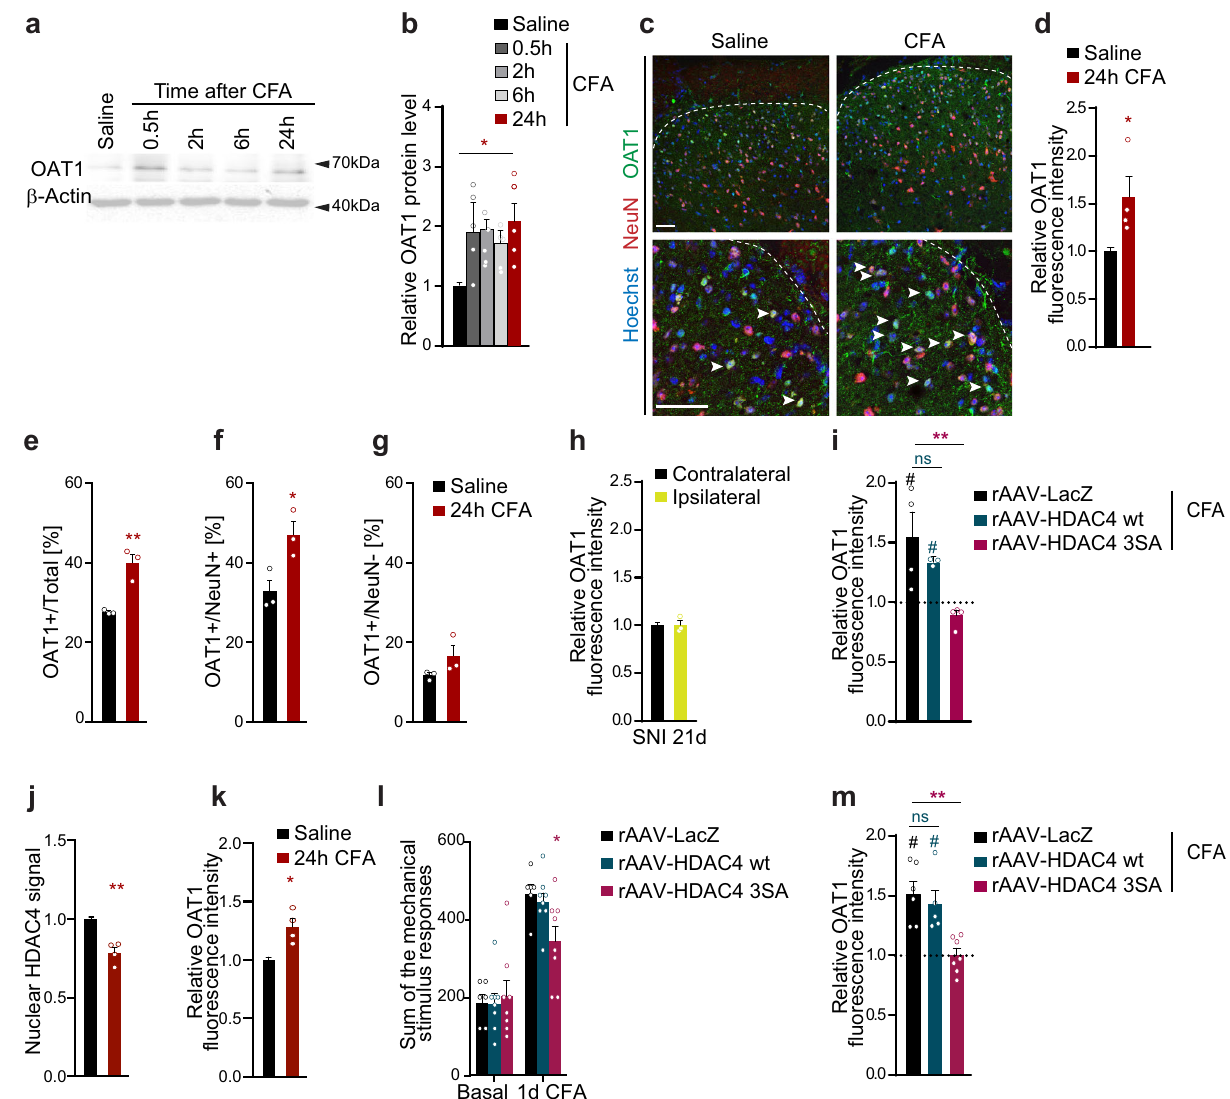
Fig. 4 Activity of the HDAC4 target OAT1 in the spinal cord mediates mechanical hypersensitivity. a Immunoblots of OAT1 and β -Actin from dorsal spinal cord segments L3 – 5. b Relative protein levels of OAT1 and β -Actin normalized to values from saline-injected control mice ( n = 5). c Representative images of dorsal horn sections of spinal segments L3 – 5 of mice 24 h after injection, OAT1 (green), NeuN (red, neuronal marker), Hoechst (blue, nuclear marker). Lower panels are a higher magni fi cation. Arrows indicate OAT1-positive and NeuN positive cells. Scale bars are 40 µ m. d Relative OAT1 immuno fl uorescence intensity in dorsal horn following injections as in ( c ) ( n = 4). e – g Co-localization analysis of OAT1-positive cells in the dorsal horn following injections 24 h earlier. Graph represents the percentage of OAT1-positive cells within the total cell population ( e , Hoechst-positive), within the neuronal population ( f , NeuN-positive), and within non-neuronal cells ( g , NeuN-negative) ( n = 3). h Relative OAT1 immuno fl uorescence intensity in dorsal horn 21 days after SNI, normalized to the contralateral side ( n = 3). i Relative OAT1 immuno fl uorescence intensity in dorsal horn laminae I – V of mice intra- spinally injected as indicated, followed by intraplantar injections of CFA or saline for 24 h (LacZ, HDAC4 3SA n = 4; HDAC4 wt n = 3). j , k Relative fl uorescence intensities of the nuclear HDAC4 ( j ) and OAT1 ( k ) signal in neurons of the dorsal horn from female mice, following intraplantar injections of CFA or saline for 24 h, normalised to contralateral (saline) sides ( n = 4). l Mechanical sensitivity of female mice intra-spinally injected as indicated, followed by unilateral intraplantar injections of CFA or saline for 24 h ( l , m ; LacZ = 7; HDAC4 wt n = 6; HDAC4 3SA n = 8). m Relative OAT1 immuno fl uorescence intensity in dorsal horn laminae I – V of female mice intra-spinally injected as in ( l ), followed by intraplantar injections of CFA or saline for 24 h prior to tissue harvest ( n = 5 – 7). Statistically signi fi cant differences were determined by two-tailed Student ’ s t -test ( d – h , j , k ), one-way ANOVA followed by Dunnett ’ s post hoc test ( b , F (4,20) = 4.281, m , F (2, 15) = 10.567), or two-way ANOVA followed by Dunnett ’ s post hoc test ( i , F (2,8) = 9.016; l , F (2, 19) = 1.087). ** p <0.01; # , * p <0.05. Asterisks (*) refer to statistical comparisons between conditions and hashtags ( # ) to comparisons relative to basal values within each condition. Each point represents the mean value derived from one mouse. Graphs represent mean + SEM. See also Supplementary Fig. Pharmacological inhibition of OAT1 reduces established long- experiments indicate that alterations in OAT1 expression in lasting in fl ammatory hypersensitivity . To explore the transla- spinal cord dorsal horn neurons can signi fi cantly in fl uence the development of nociceptive hypersensitivity, and as such provide tional potential of our fi ndings, we searched for FDA-approved a mechanistic molecular link between epigenetic modulation of inhibitors of OAT1 activity and found that the uricosuric drug gene expression and persistent in fl ammatory sensitization. Probenecid (PBN) is, at present, the sole OAT1 inhibitor suitable for